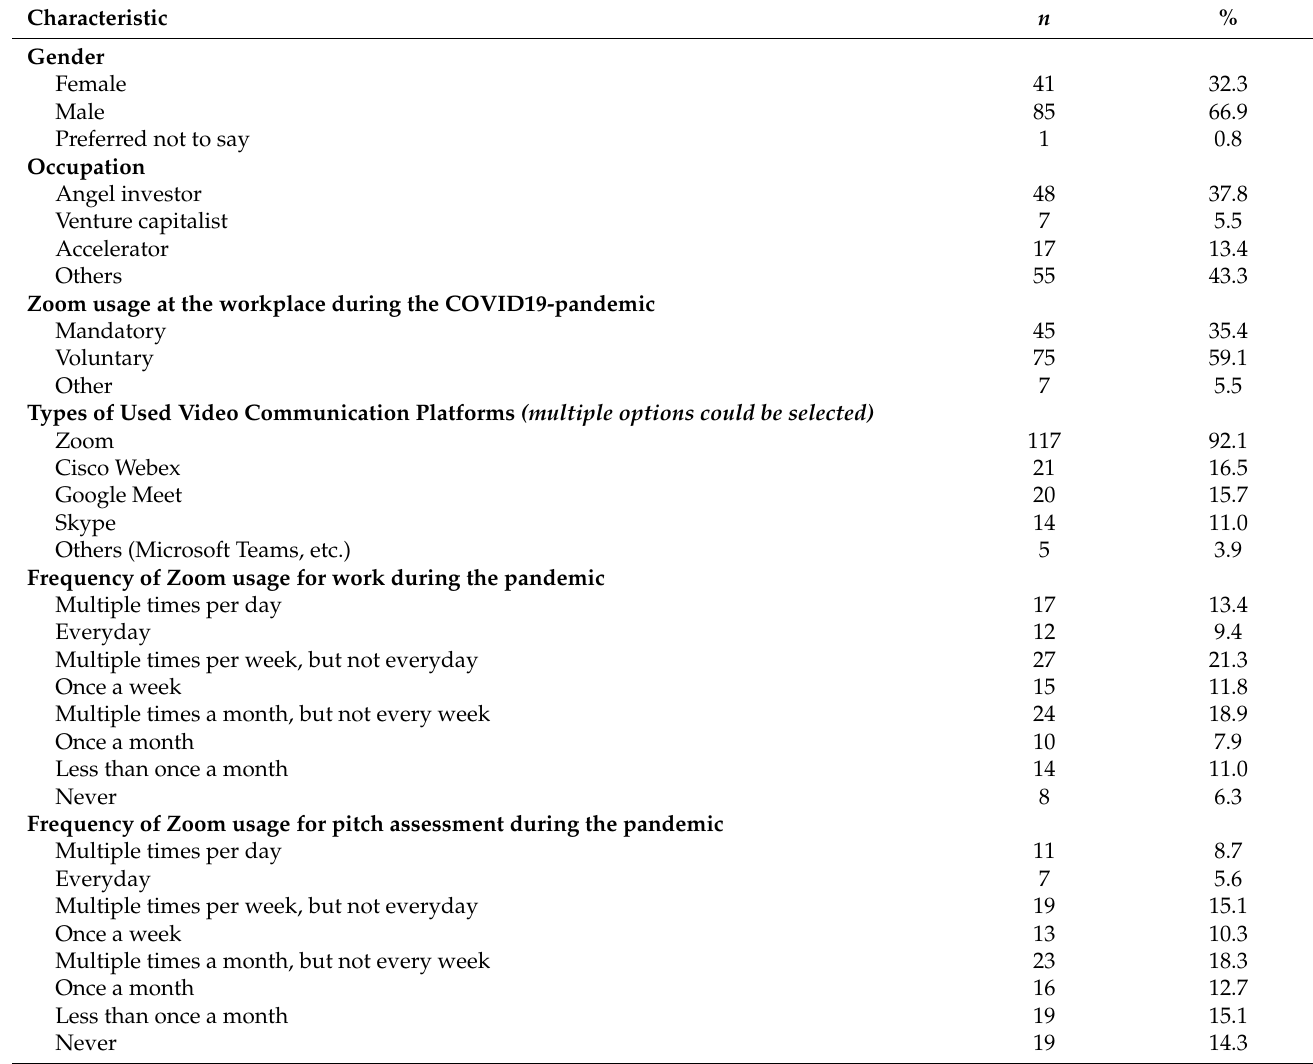
Table 1. Demographic characteristics of the